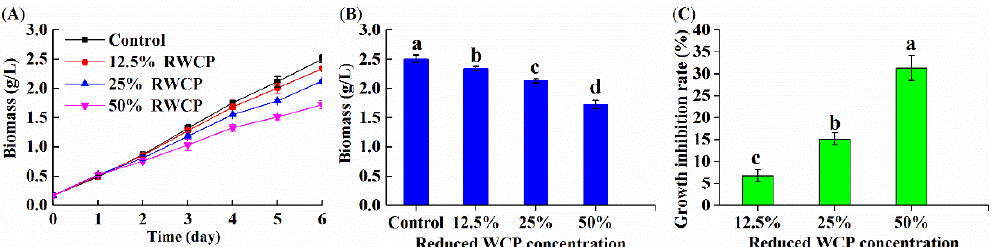
Figure 5. Effects of different concentrations of reduced caprolactam wastewater (RWCP) on the growth of Arthrospira platensis . ( A ) Growth curves of Arthrospira platensis , ( B ) final biomass concentration, ( C ) growth inhibition rate (%). Error bars represent the standard deviation ( n = 3). Data with different letters indicate significant differences ( p < 0.05) between the control and treatments.